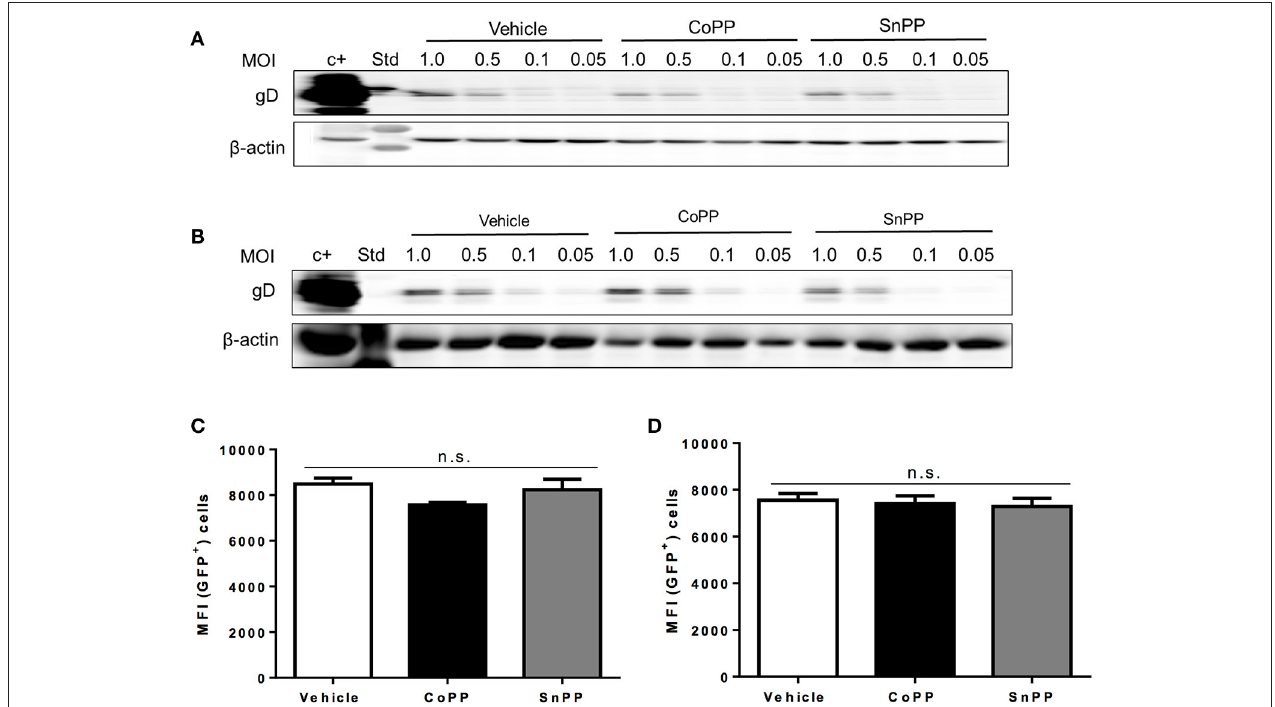
FIGURE 3 | Pharmacological induction of HO-1 activity does not interfere with virus binding to the cell surface nor capsid entry into the cytoplasm. Western blot analyses for determining virus binding to the surface of (A) . Vero cells and (B) . HeLa cells. Cells were incubated with varying doses of virus for 5h at 4 ◦ C, washed with saline buffer and then immediately prepared for protein extraction. HSV gD protein expression was assessed to determine the amount of virus bound to the surface of cells. (C,D) Flow cytometry analyses measuring virus-derived GFP fluorescence of capsids internalized into the cytoplasm 2h post-infection with a MOI of 100 after treatment with CoPP, SnPP, or vehicle in Vero cells (left) and HeLa cells (right). Cells were thoroughly washed with saline buffer and treated with trypsin to remove any surface-bound virus before analysis. Data are means ± SEM of three independent experiments. Representative images are shown for Western blots. Two-way ANOVA, and Tukey’s multiple comparison test were used for statistical analyses (n.s., non-significant